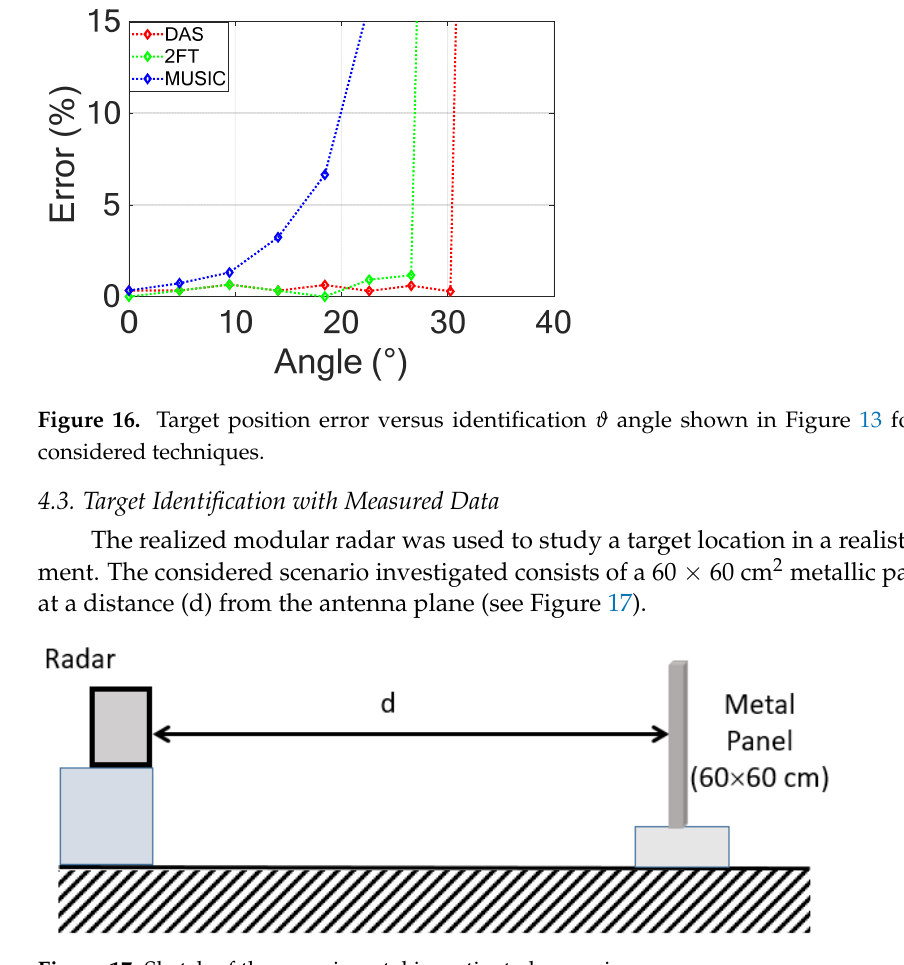
Figure 16. Target position error versus identi fi cation 𝜗 angle shown in Figure 13 for the three con- sidered techniques.